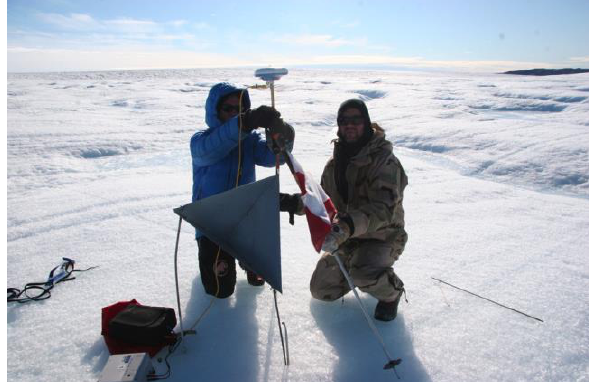
Figure 4. Installing of corner reflector (photo from expedition,